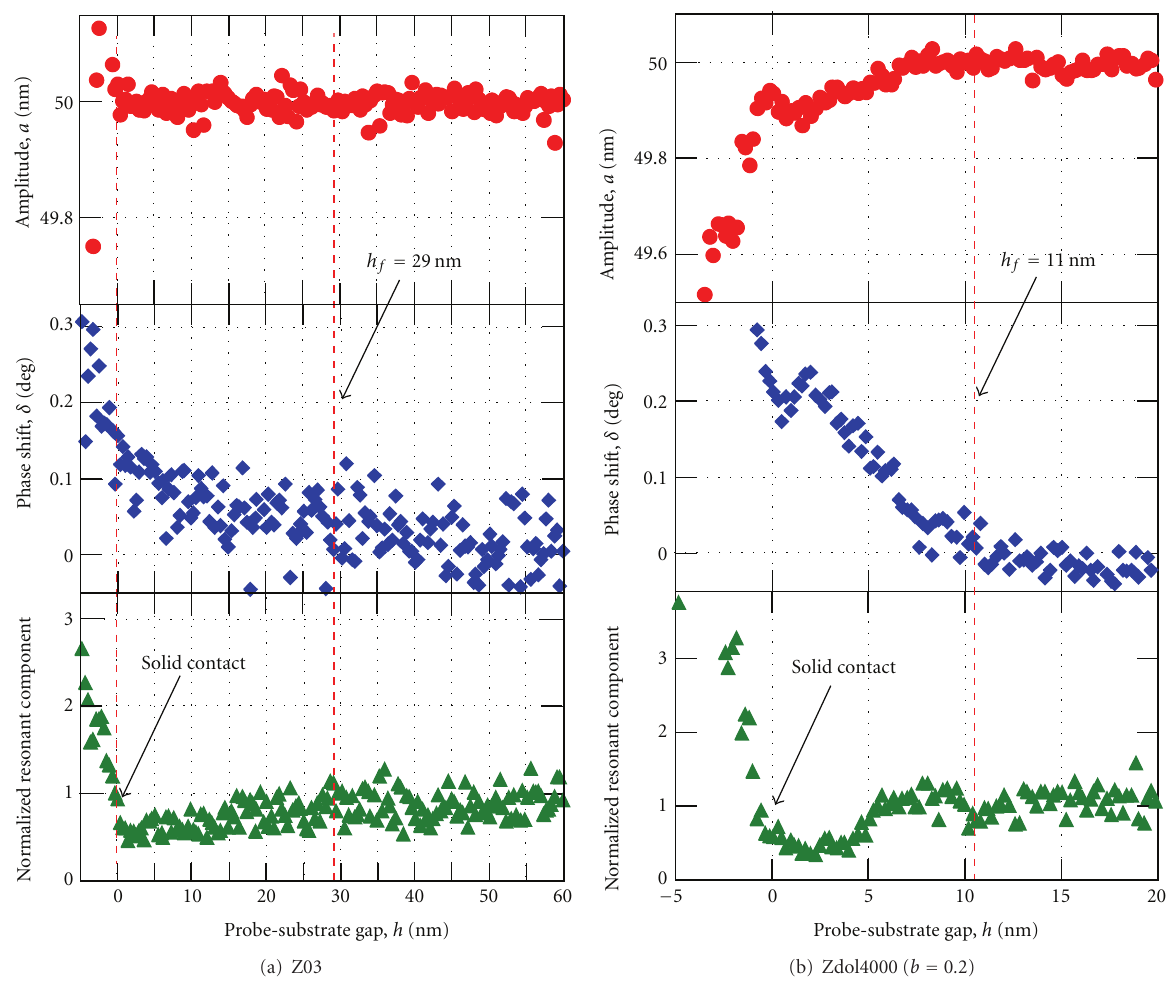
Figure 11: Probe amplitude, phase shift, and normalized resonant component measured for (a) Z03 and (b) Zdol4000 with a bonding ratio of 0.2 in the separating process